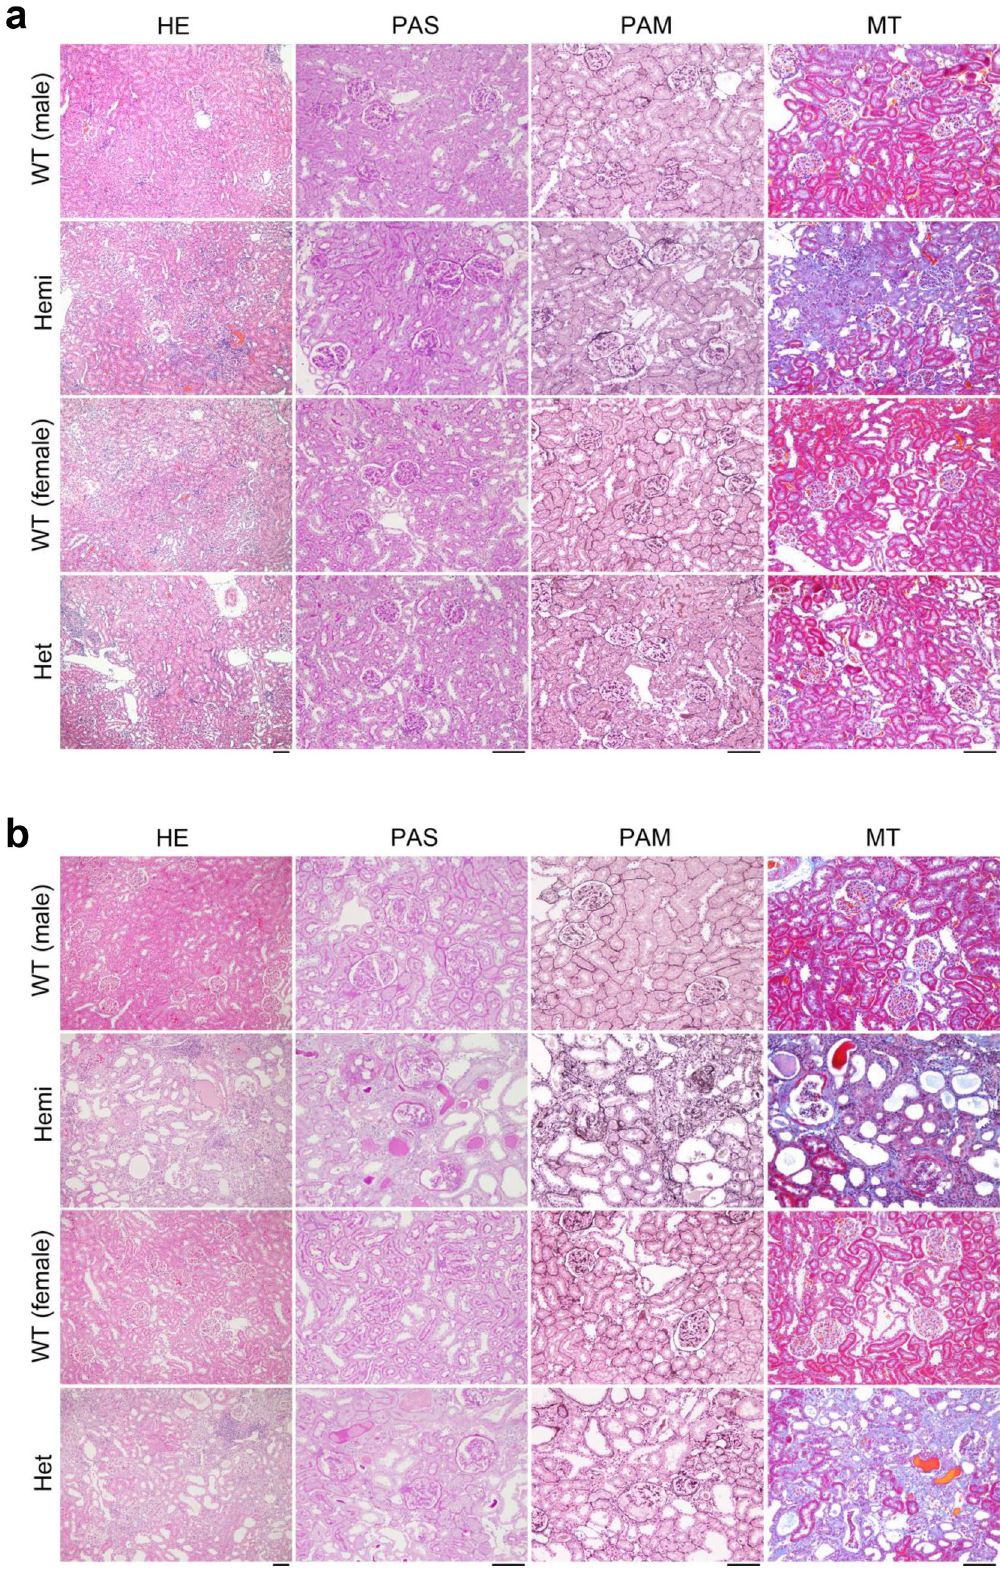
Figure 2. Histological analyses of Col4 α 5 deficient kidneys. (a,b) Representative microscopic images in wildtype (WT) and Col4 α 5 mutant (Hemi; hemizygous males, Het; heterozygous females) rats at 8 weeks (a) and 20 weeks (b) of age. These tissue sections were prepared and stained with hematoxylin and eosin (HE), periodic acid Schiff (PAS), periodic acid methenamine silver (PAM), and Masson trichrome (MT). Scale bars , 100